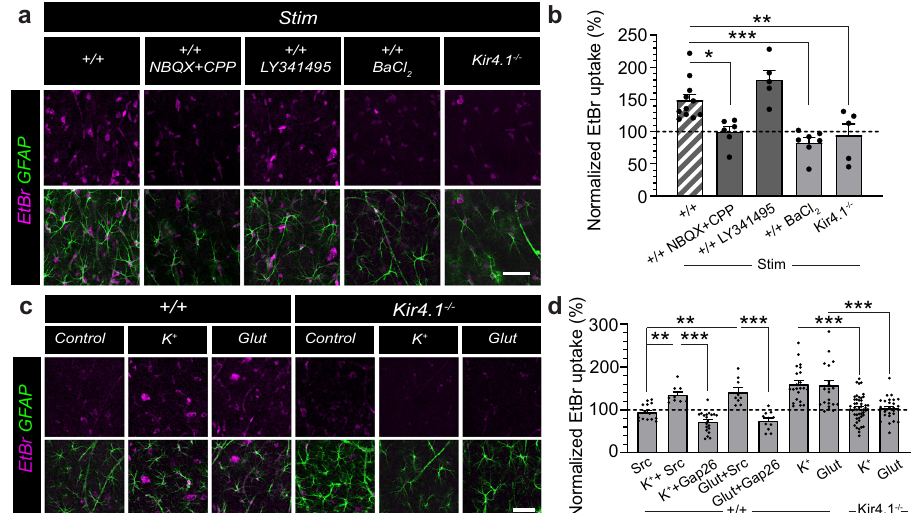
Fig. 7 Activity-dependent Cx43 hemichannel function is mediated by glutamatergic synaptic activity and potassium activation of Kir4.1 channels. Acute hippocampal slices were loaded with ethidium bromide (EtBr) under stimulated conditions in the absence or presence of various blockers. a , b Sample images of EtBr uptake (magenta) in hippocampal GFAP-immunolabeled astrocytes (green) are shown in ( a ) and quanti fi ed in ( b ). Stimulation- enhanced uptake was blocked in the presence of NBQX + CPP (20 μ M, n = 6, p = 0.0112 with wild-type control, + / + , n = 11, one-way ANOVA with Bonferroni ’ s post hoc test), but not LY341495 (20 μ M; n = 5, p = 0.2433 with + / + , one-way ANOVA with Bonferroni ’ s post hoc test), indicating the